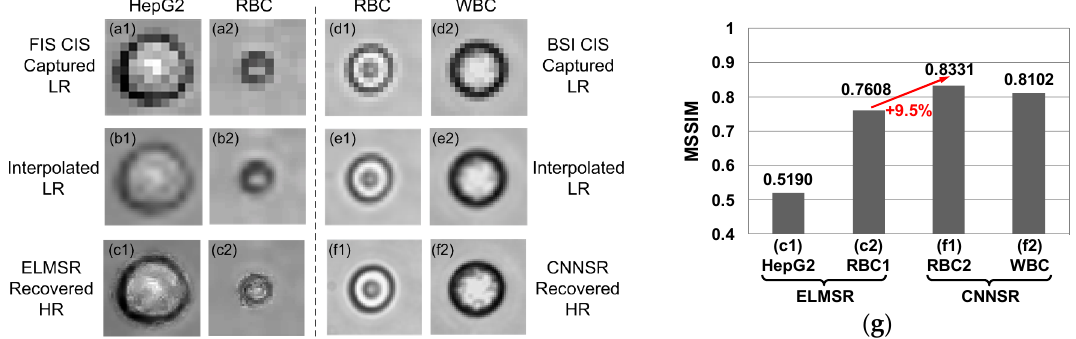
Figure 7. Example of HepG2, RBC, and WBC images in ELMSR and CNNSR testing: ( a ) raw LR images captured by FSI CIS with pixel pitch 2.2 µm; ( b ) interpolated LR images; ( c ) ELMSR recovered HR images; ( d ) raw LR images captured by BSI CIS with pixel pitch 1.1 µm; ( e ) interpolated LR images; ( f ) CNNSR recovered HR images, showing better performance in resolution improvement; and ( g ) the mean structural similarity (MSSIM) results for on-line recover cell images.